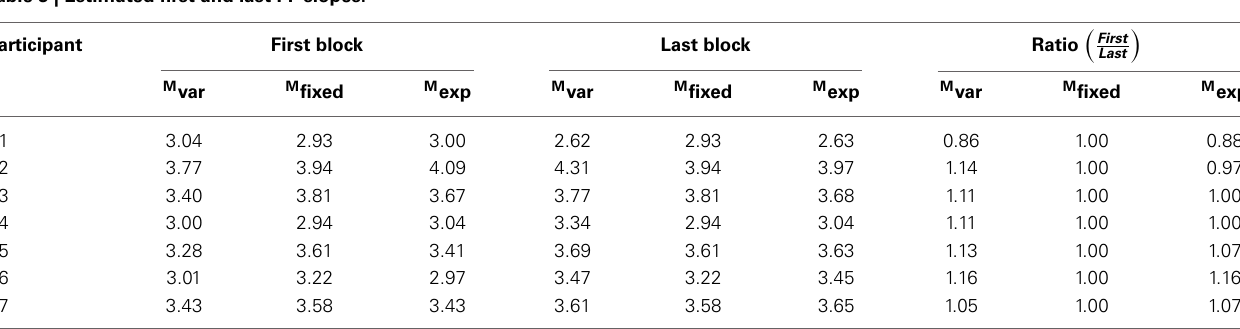
Table 3 | Estimated first and last PF slopes.